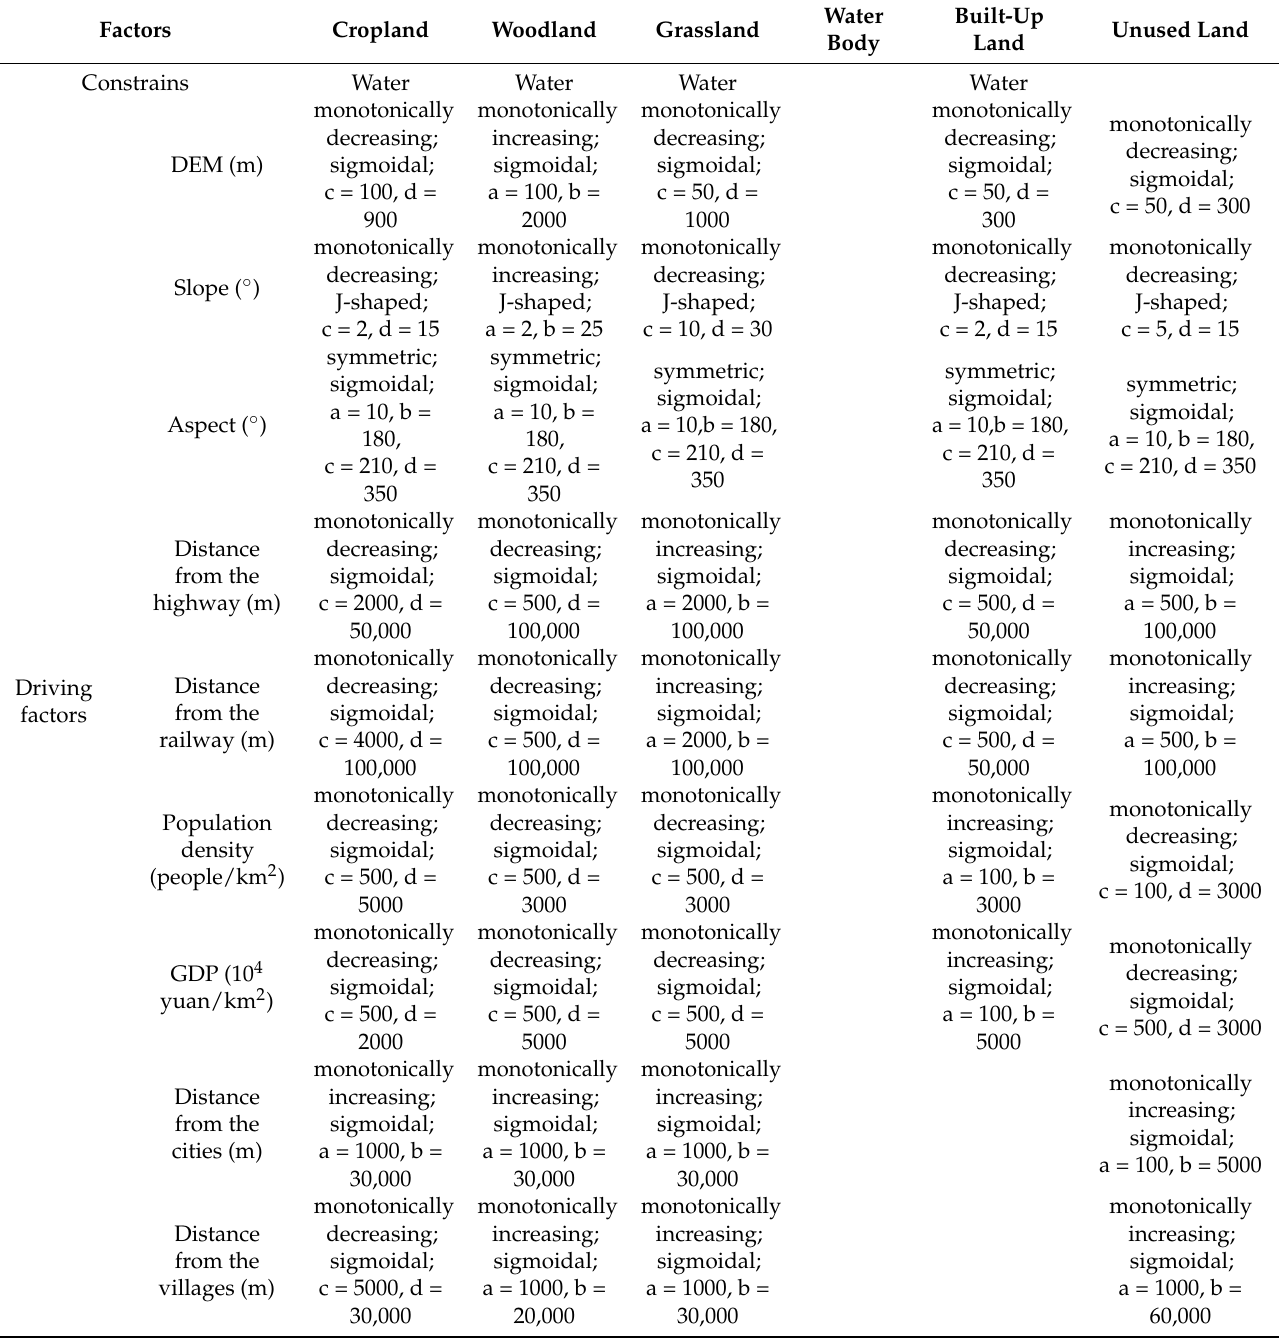
Table 1. Function information of driving factors and constraints of land-use type transition. Factors Cropland Woodland Grassland